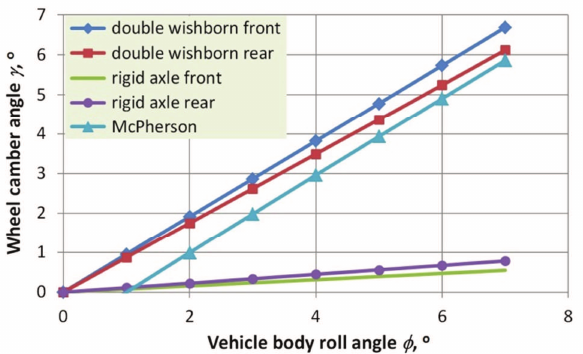
Fig. 5. The inclination of the vehicle caused by the lateral force [11] The impact of tires deflection was omitted.